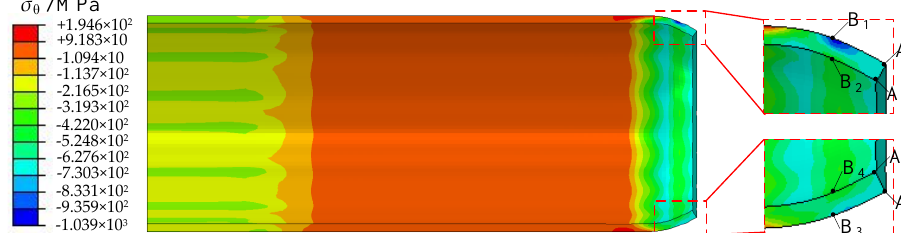
Figure 19. Reducing stage. Figure 19. Reducing